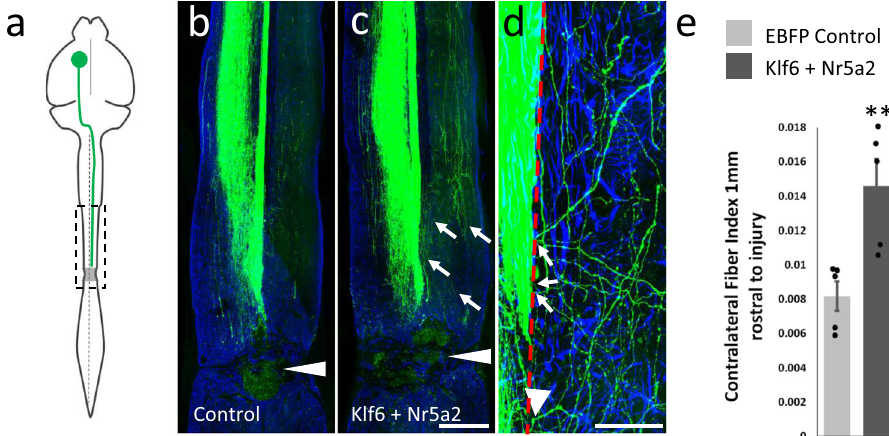
Fig. 6 Combined expression of Klf6 and Nr5a2 in corticospinal neurons increases collateral sprouting but not extension through sites of spinal lesion. a Adult mice received cortical injection of AAV-EGFP tracer with AAV-Cre control or combined AAV-Klf6 and AAV-Nr5a2, and T10/11 spinal crush injuries. b , c Horizontal spinal sections with examples of CST axons (green), spinal injuries (arrowheads), and reactive astrocytes (GFAP, blue). Neither EBFP control nor KLF6/Nr5a2-treated axons traverse the injury, but Klf6/Nr5a2-treated axons display cross-midline sprouting rostral to the injury (arrows). d CST collaterals crossing the midline (dotted line) and extending into contralateral cord. e Quanti fi cation of CST axons that extend 400 µ m from the midline, normalized to total CST axons counted in the medullary pyramids, shows a signi fi cant elevation in cross-midline growth (** p = 0.0069, two- tailed t -test, n = 5 control, 5 Klf6/Nr5a2). Scale bars are 1 mm ( b , c ) and 100 µ m ( d ). Dots in e represent values of single animals. Source data are provided as a Source data fi isolate CST neurons, nuclear-localized fl uorophores and TFs were expressed by cervical injection of Retro-AAV2, which results in highly ef fi cient and selective transgene expression by retrograde transduction 35 (Fig. 7a, b). Animals received pyramidotomy injury, followed 1 week later by puri fi cation of labeled nuclei of CST neurons from the spared hemisphere by fl ow cytometry, isolation of messenger RNA, and construction and sequencing of RNA libraries. Differential gene expression was determined using EdgeR software 36 . Compared to tdTomato control, single expression of Klf6 resulted in the upregulation of 208 transcripts (transcripts with fragments per kilobase of transcript per million mapped reads (FPKM) > 5 and log2fold change>1; p -value < 0.05, false discovery rate (FDR) < 0.05) (Fig. 7c). Reminiscent of prior fi ndings in cultured neurons 7 , network analysis of Klf6-responsive genes revealed subnetworks with functions highly relevant to axon